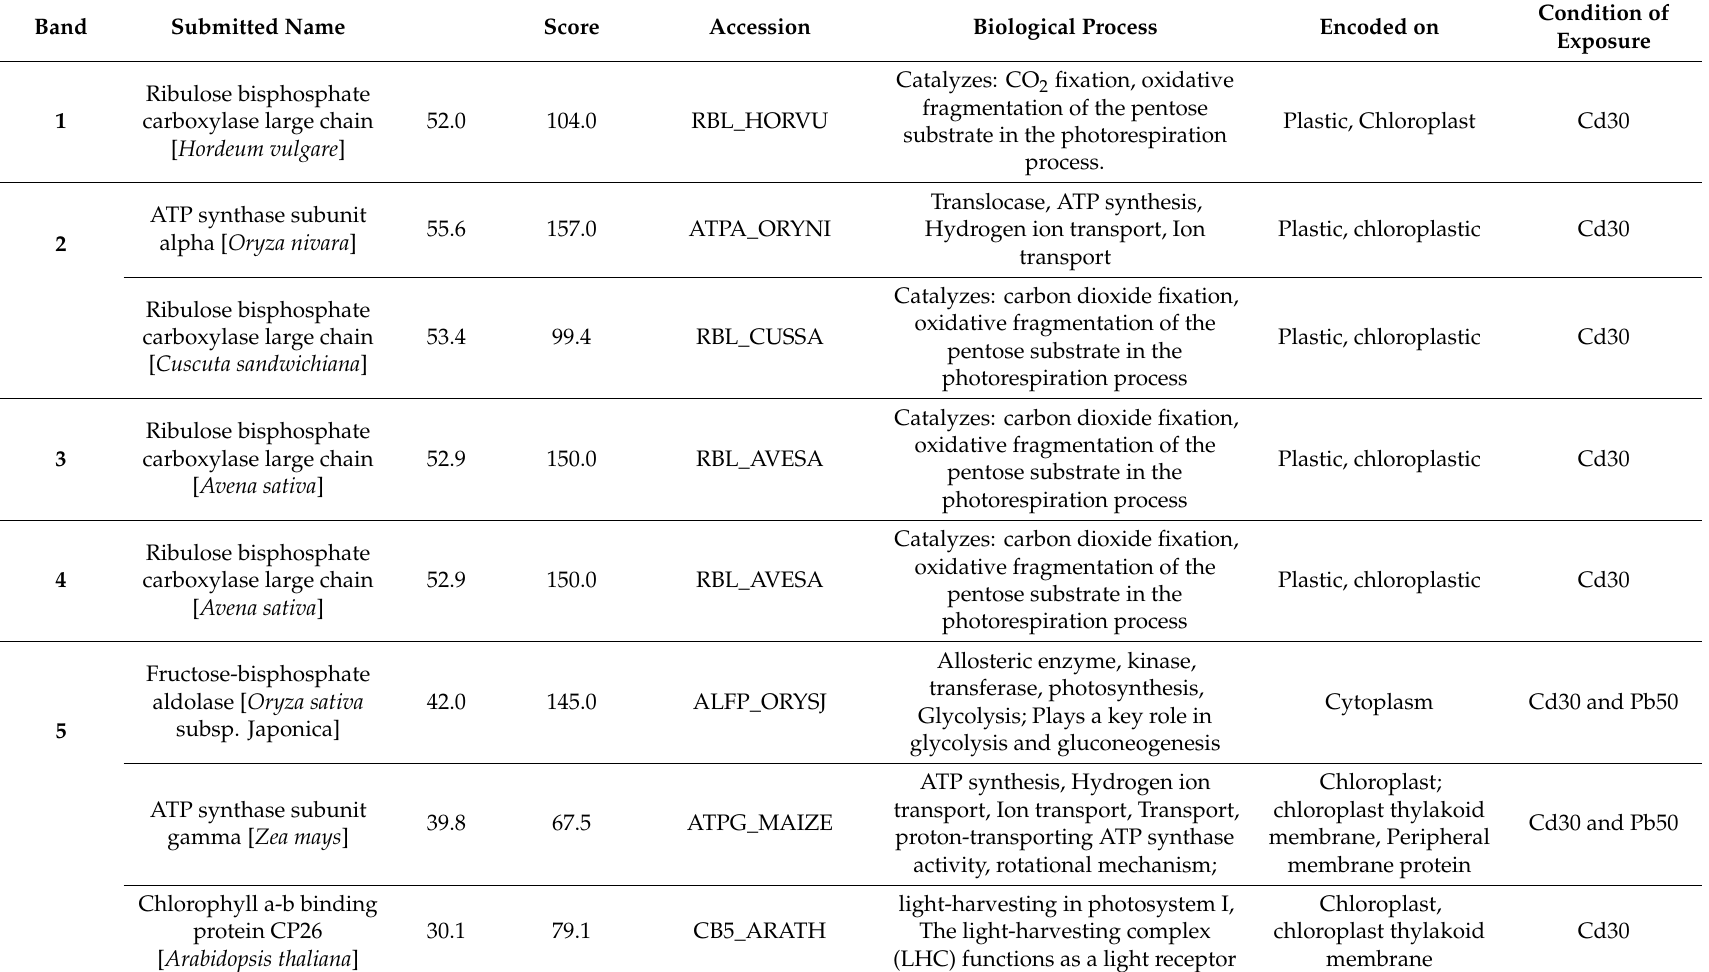
Table 3. Carbonylated proteins identified from P. fasciculatum Willd (Ex Flugue) leaves exposed at Cd (30 days) and Pb (60